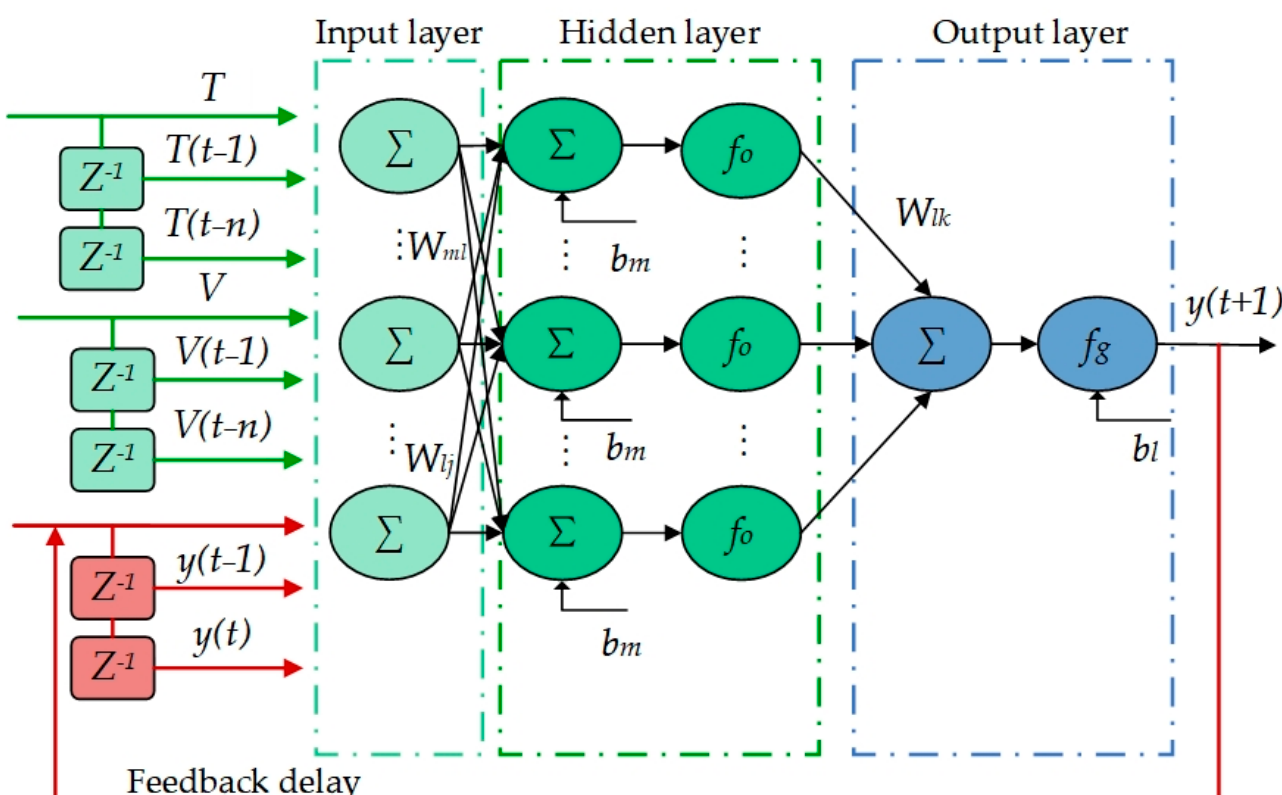
Figure 4. Topology of the NARX neural network.